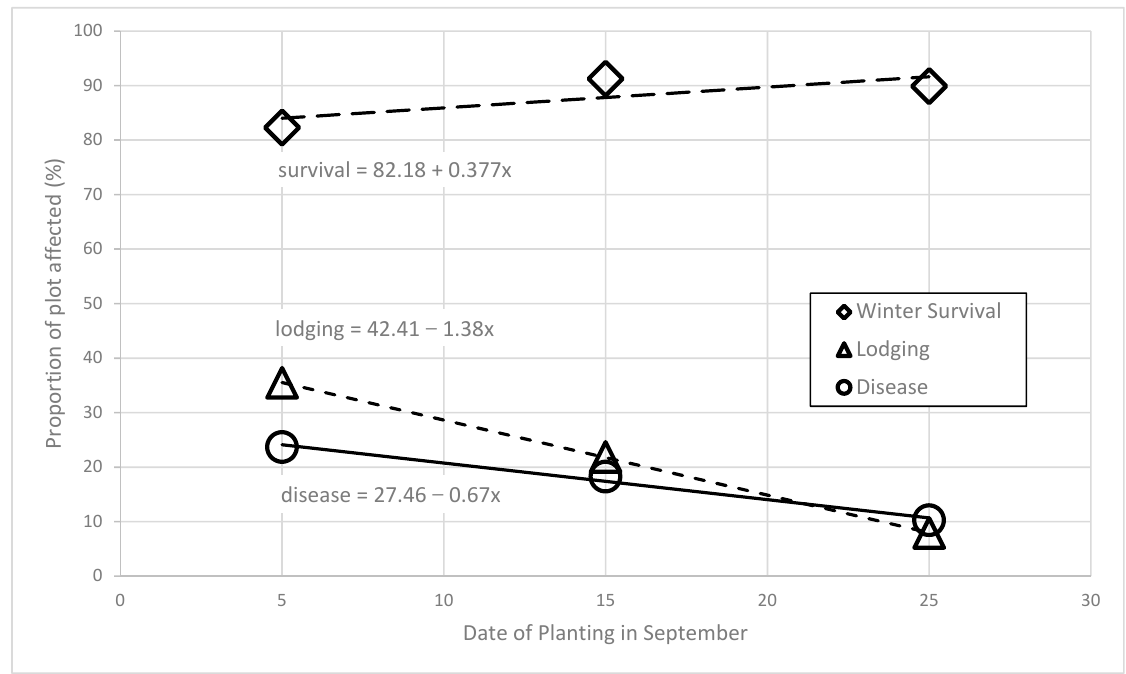
Figure 2. Winter survival, lodging, and disease (% of plot) as a function of date of planting.